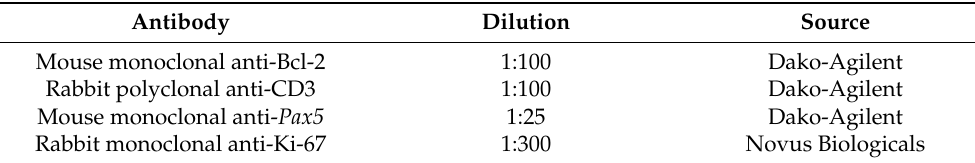
Table 1. Antibodies employed, dilution, and source. Antibody Dilution Source Mouse monoclonal anti-Bcl-2 1:100 Dako-Agilent Rabbit polyclonal anti-CD3 1:100 Dako-Agilent Mouse monoclonal anti- Pax5 1:25 Dako-Agilent Rabbit monoclonal anti-Ki-67 1:300 Novus